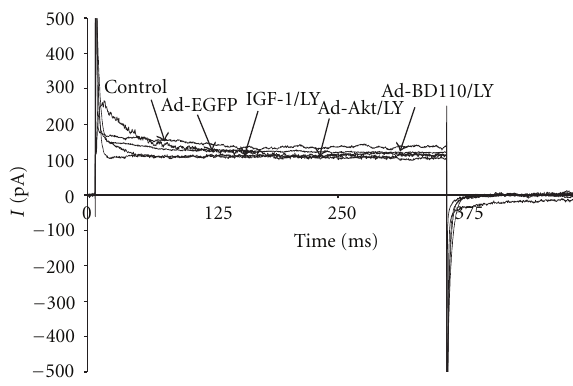
Figure 2: Recording representative of the time courses for the e ff ects of IGF-1, Ad.Akt, and Ad.BD110 treatments on I K of normal neonatal rat cardiomyocytes at the clamp voltage of +30mV.